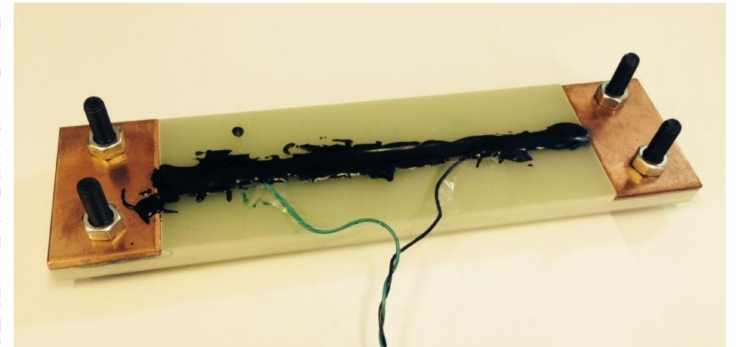
Figure 2. Prepared sample with Stycast black